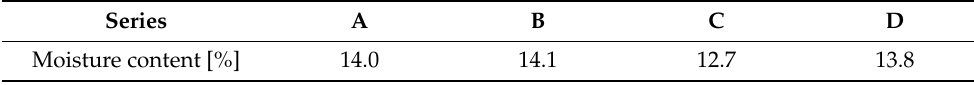
Table 4. Average moisture content value of laminated veneer lumber in each series.